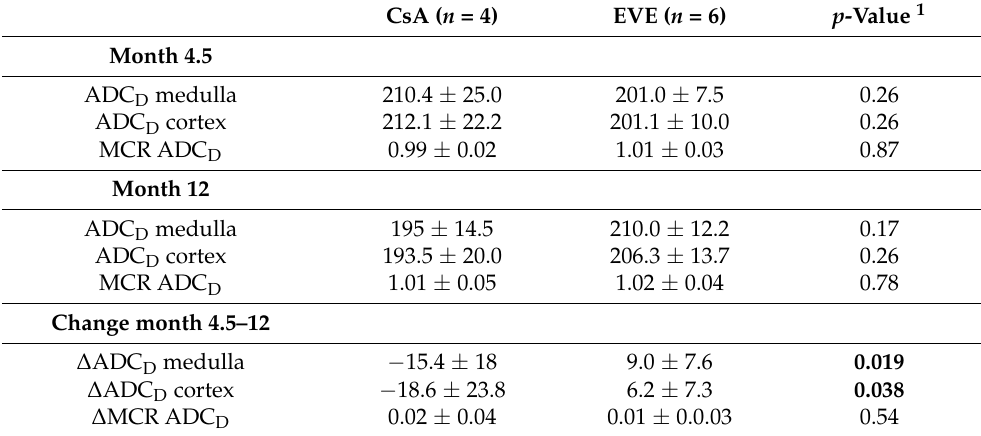
Table 3. DWI-derived pure diffusion coefficient according to medication group and time-point.